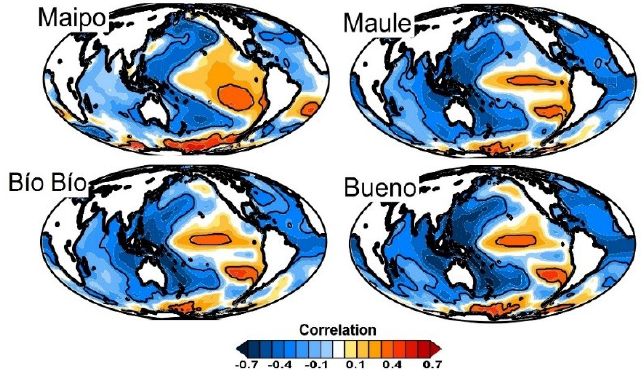
Figure 10. Pointwise correlations between hydropower and global SSTs between 1970 and 2016. Black contours indicate statistical significance at p = 0.05 according to the Pearson’s product moment correlation coefficient.